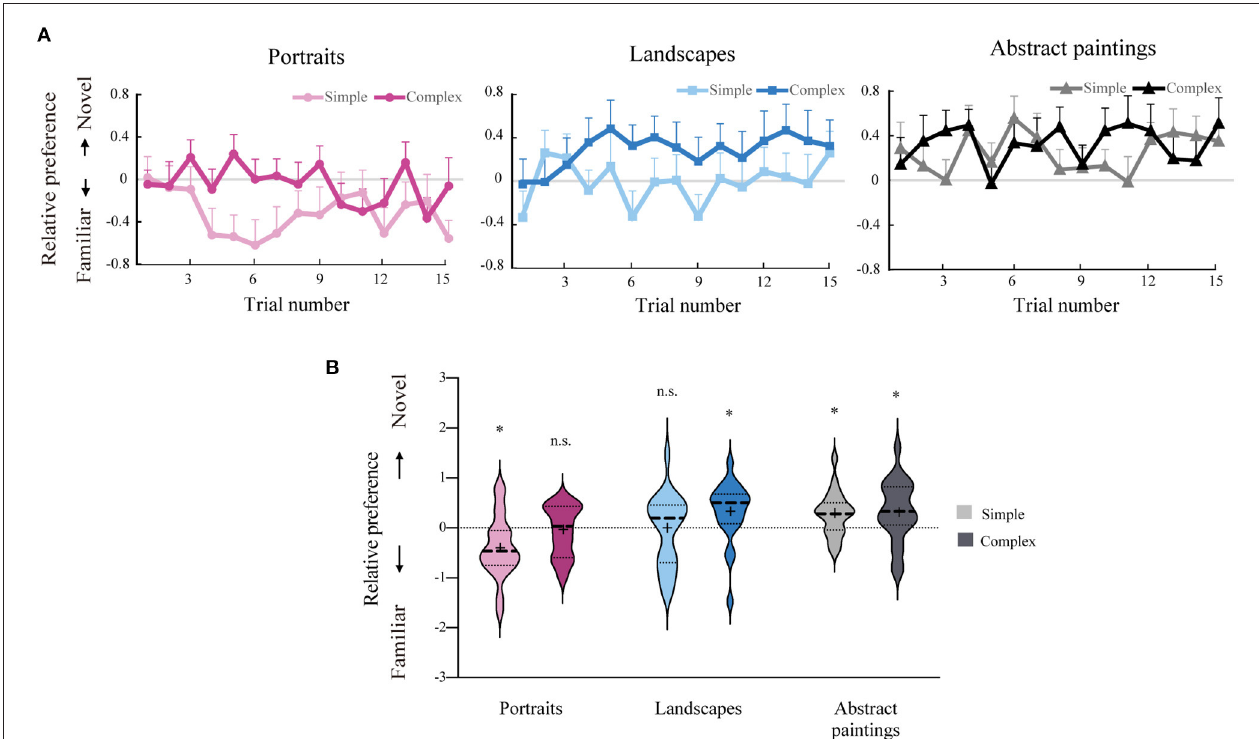
FIGURE 2 | The time course and summary of familiarity-novelty preference. (A) The time course of familiarity-novelty preference. Time courses of preference values through a subblock were averaged for each complexity condition. The mean relative preference values are shown for each trial from the first to the fifteenth trial. The negative values of the y-axis indicate a preference for repeated (i.e., familiar) paintings, and the positive values of the y-axis indicate a preference for novel paintings. Error bars represent + 1 standard error of the mean. (B) Summary of familiarity-novelty preference. Violin plots illustrate the distributions and the descriptive statistics of the individual mean relative preference values from the fourth to the fifteenth trial for each of the six conditions. The cross hairs indicate the mean. The middle horizontal lines indicate the median, and the lower and upper lines indicate the first and third quartiles. Asterisks indicate a significant difference from zero, as per the results of one-sample t -tests (* p < 0.05, n.s., not significant).